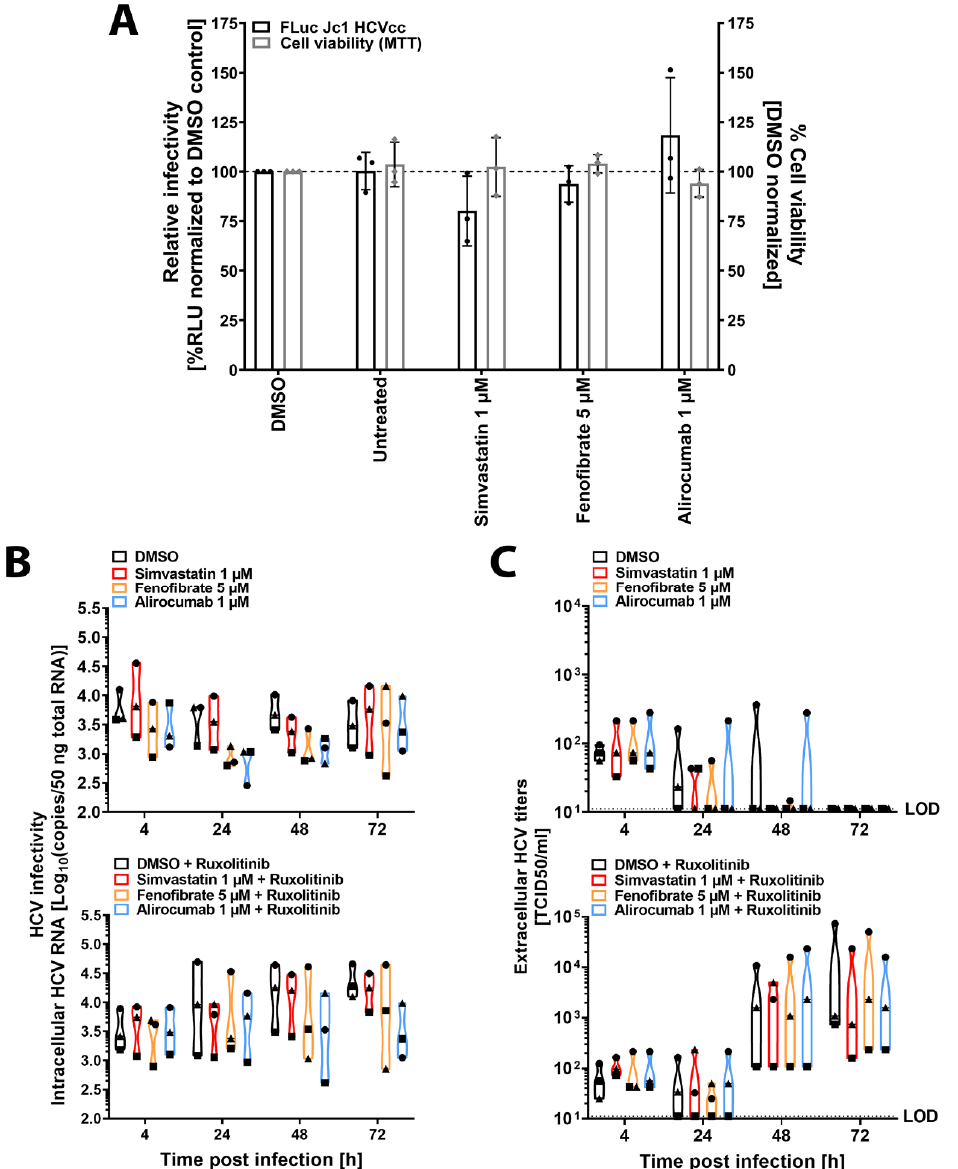
Figure 2. Lipid-lowering drugs do not affect HCV genotype 2a infection of Huh-7.5 or primary human hepatocytes. Cell culture-derived (HCVcc) infection (black bars) and viability (grey bars) in Huh-7.5 cells ( A ). Cells were pretreated for 24 h prior to infection with the indicated drug concentrations. Pretreated cells were infected with an FLuc reporter virus (Jc1-Fluc) in the presence of drug for 4 h. Virus inoculum was removed, and cells treated with LLDs for 68 h. FLuc activity was measured and normalized to solvent control (DMSO). Cell viability determined by MTT assay. Graph represents the average of 3 independent experiments with 3 technical replicates each. Dots show individual values of each experiment. Error bars represent the SD. For statistical analysis, a multiple comparison two-way ANOVA with a Dunnett correction was performed ( α = 0.05, degrees of freedom (DF) = 20). HCVcc infection of primary human hepatocytes (PHH) ( B , C ). PHH from three donors were pretreated for 24 h with LLDs at the indicated concentrations in the absence (B-C, upper panels) or presence ( B , C , lower panels) of the JAK/STAT inhibitor ruxolitinib (10 µ M). Cells were then infected for 4 h with 3.75 × 10 5 TCID50s of the GT2a cell-cultured adapted HCVcc p100pop in combination with the drugs. Virus inoculum was removed, and drugs added until the indicated times post-infection. Intracellular RNA copies ( B ) and extracellular infectious particles ( C ) were quantified by RT-qPCR and TCID50 assay, respectively. Graphs represent the distribution and median of each treatment of all donors. Each dot represents an individual donor (circle, triangle, square). Statistics were performed using a multiple comparison two-way ANOVA with a Dunnett correction ( α = 0.05, degrees of freedom (DF) =